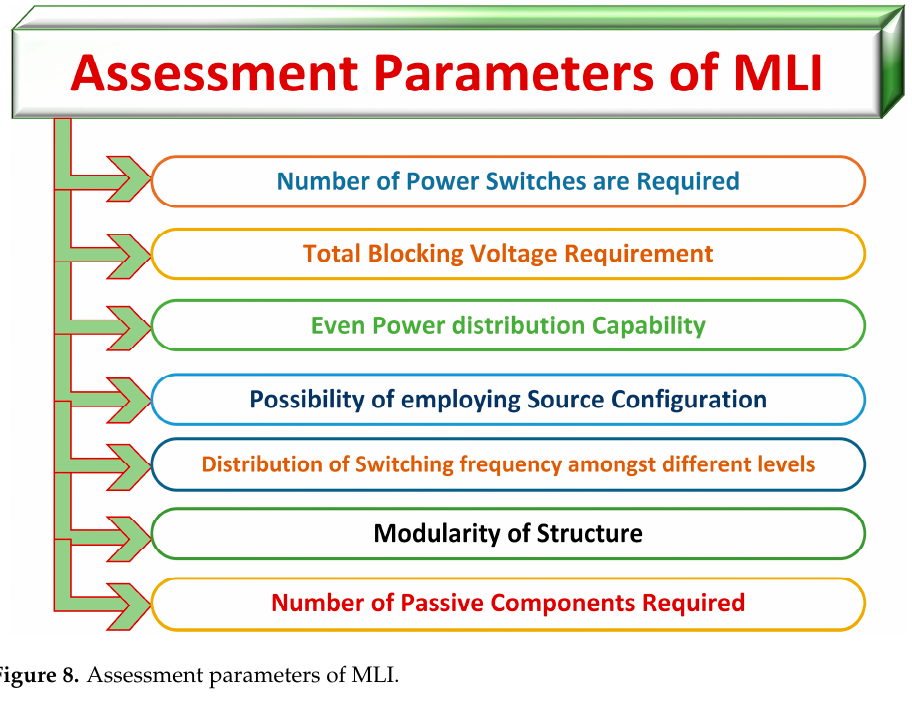
Figure 8. Assessment parameters of MLI.